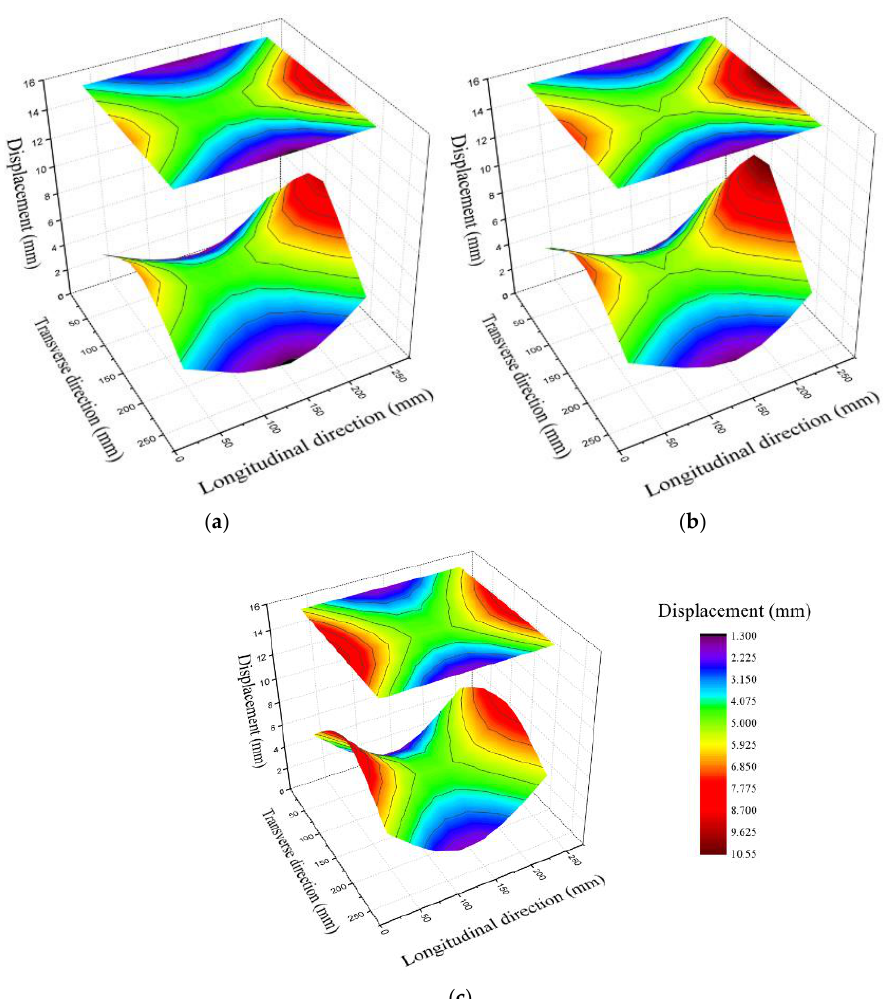
Figure 10. Deformation graphs: ( a ) symmetrical method (SM), ( b ) backward method (BM) and ( c ) single-pass method (SP).